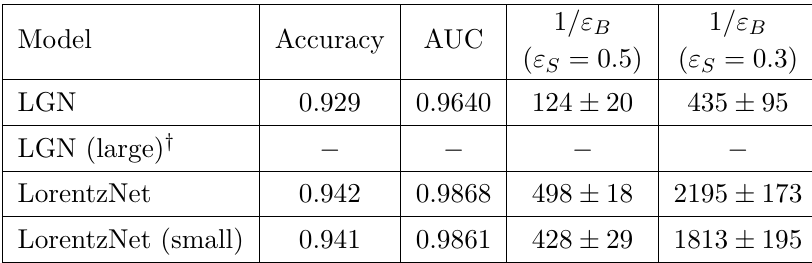
Table 6 . Inference time of each model on both CPU and GPU along with their parameter numbers. Models are executed on a cluster with an Intel Xeon CPU E5-2698 v4 and an Nvidia Tesla V100 32GB. Both of the inference times are collected with a batch size of 100.